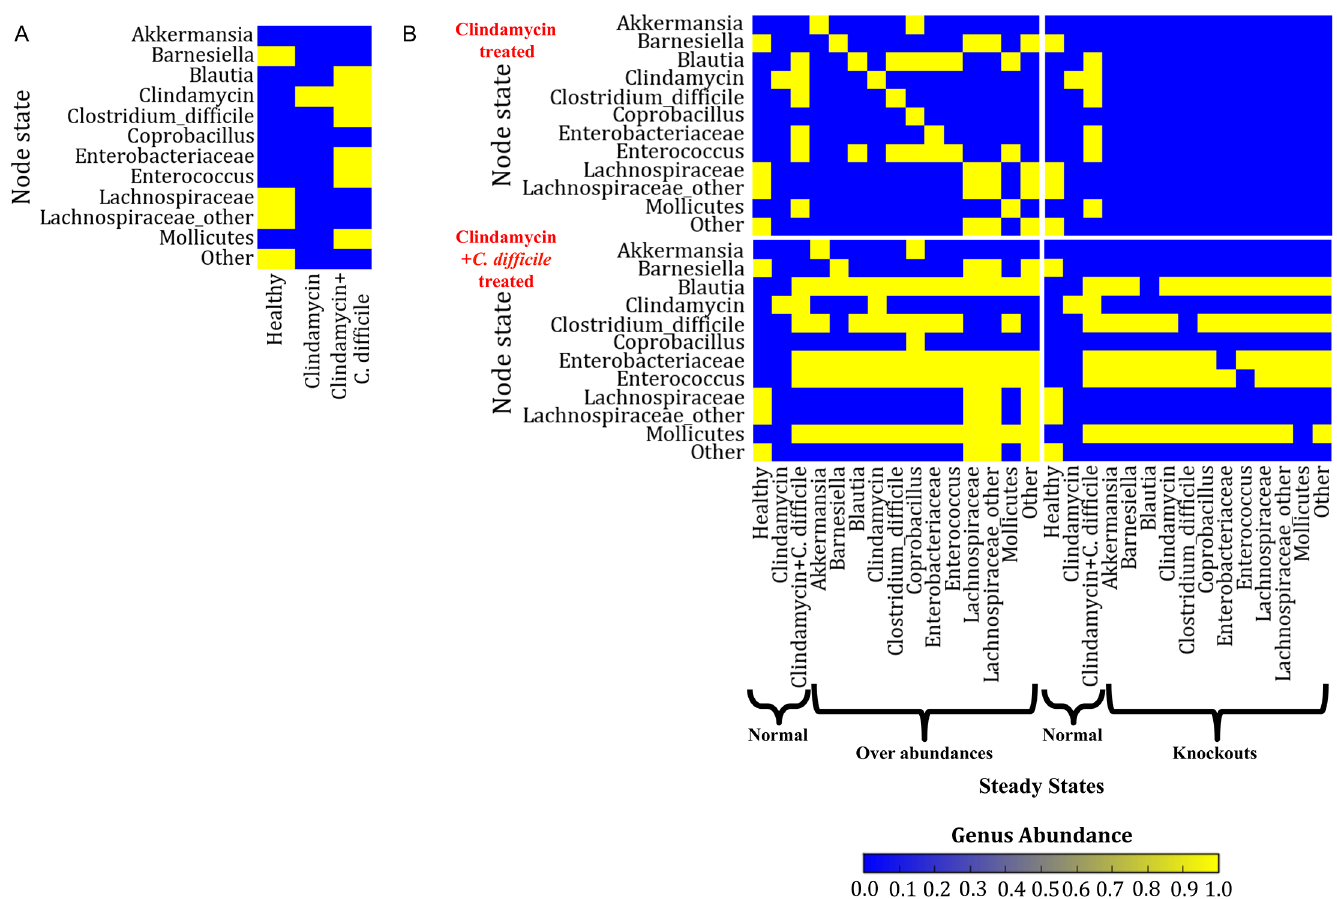
Fig 3. Steady states and node perturbations in the gut microbiome model. A) Heatmap of the three steady states in the gut microbiome model. These steady states are identical to steady states identified in the three experimental groups. B) The effect of node perturbations represented by four heatmaps. On the Y-axis of each of the four heatmaps are nodes (genera) in each steady state. On the x-axis of each of the four heatmaps are the steady states found under normal model conditions (i.e. no node perturbations) and also the specific perturbation of a single network node. The two heatmaps in the left column of the figure demonstrate the effect of addition (forced overabundance) of individual genera, and the two heatmaps in the right column of the figure demonstrate the effect of removal (knockout) of individual genera. The top row heatmaps show the effect of node perturbations on the clindamycin treated group and the bottom row heatmaps show the effect of node perturbations on the clindamycin+ C . difficile treatment group. * Genus abundance of 0 means present in 0% of asynchronous simulations and is indicated in blue; Genus abundance of 1 means present in all (100%) of asynchronous simulations, shown in yellow. n = 1000 simulations were applied for all Boolean model